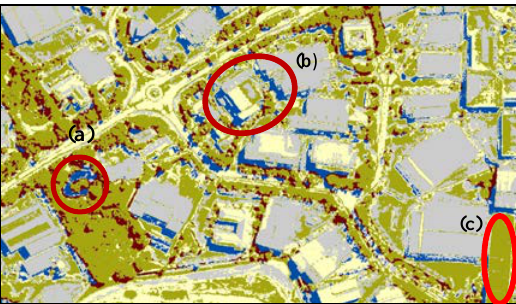
Figure 5: Corresponding classifications derived from figure 3 of the high spatial resolution Pleiades image (a) area showing water; (b) area showing shadows of buildings; (c) area showing roof of a